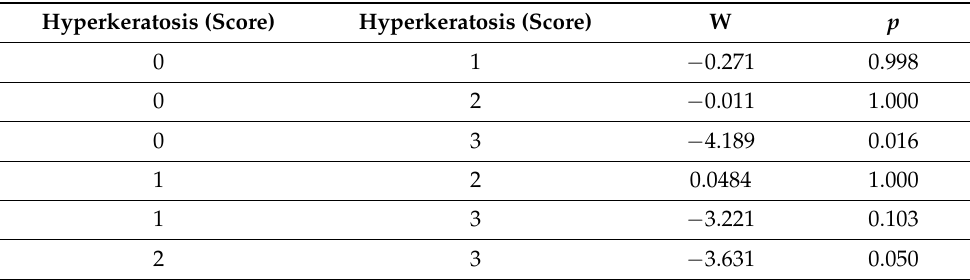
Table 8. Dwass–Steel–Critchlow–Fligner pairwise comparisons (intensity ratio) for the variable “hyperkeratosis” after the statistically significant kruskal-Wallis test. Column 1 and Column 2 represent the paired hyperkeratosis scores in comparison.